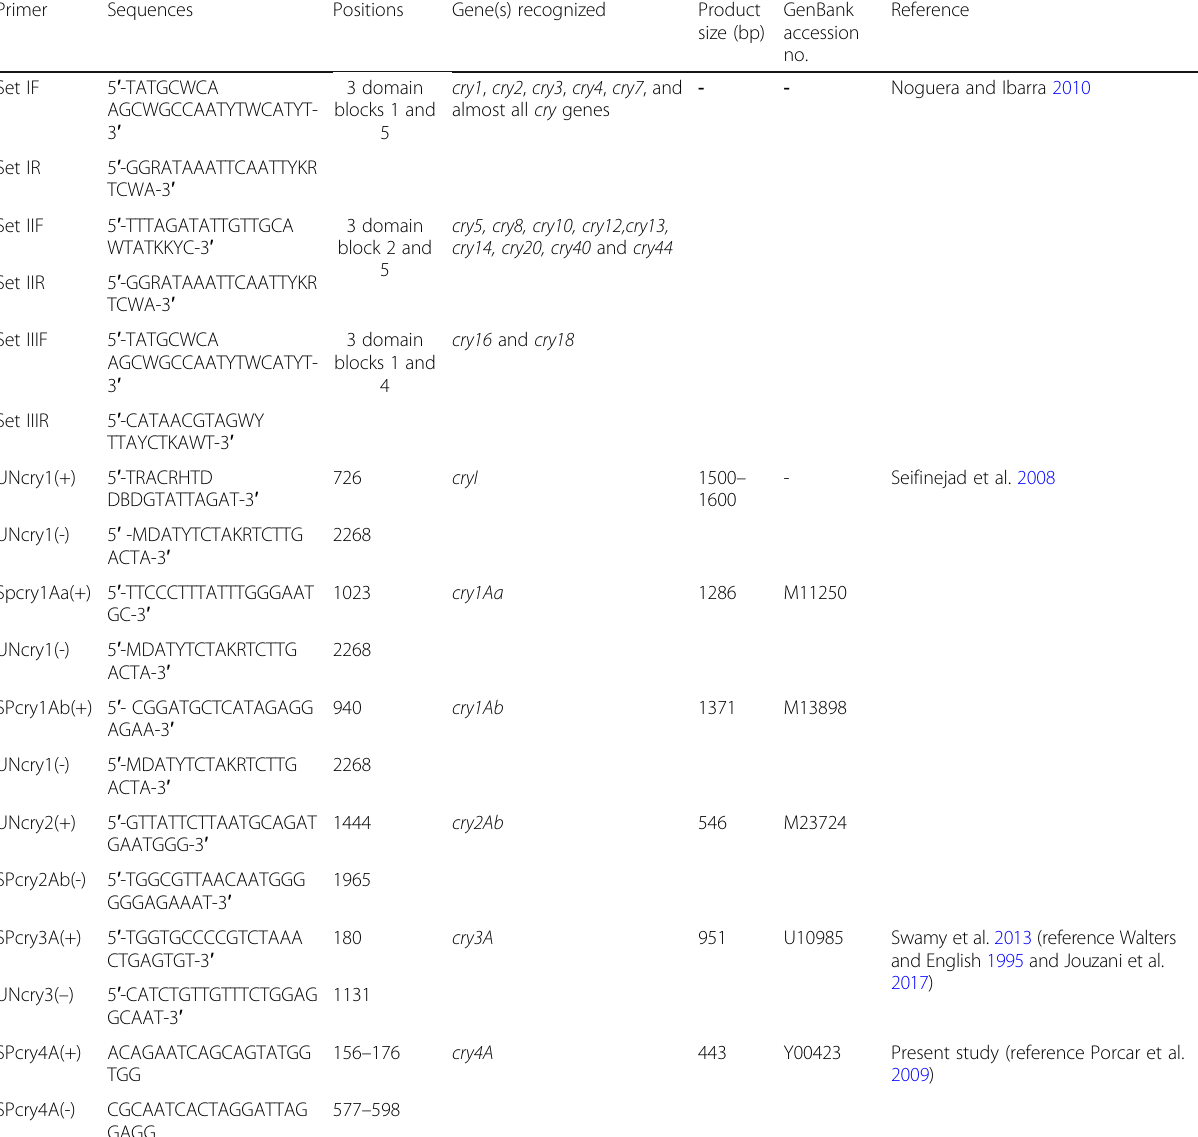
Table 1 Primers used to screen Aphidicidal cry genes from native B. thuringiensis isolates